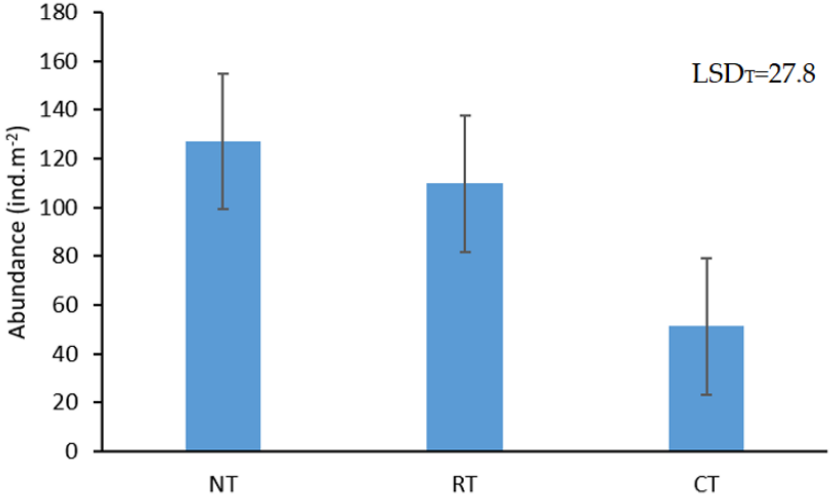
Figure 2. The variation in abundance of soil macrofauna in three treatments of no-till (NT), rotational tillage (RT) and conventional tillage (CT) recorded after 17 years of trial establishment. T = treatment.